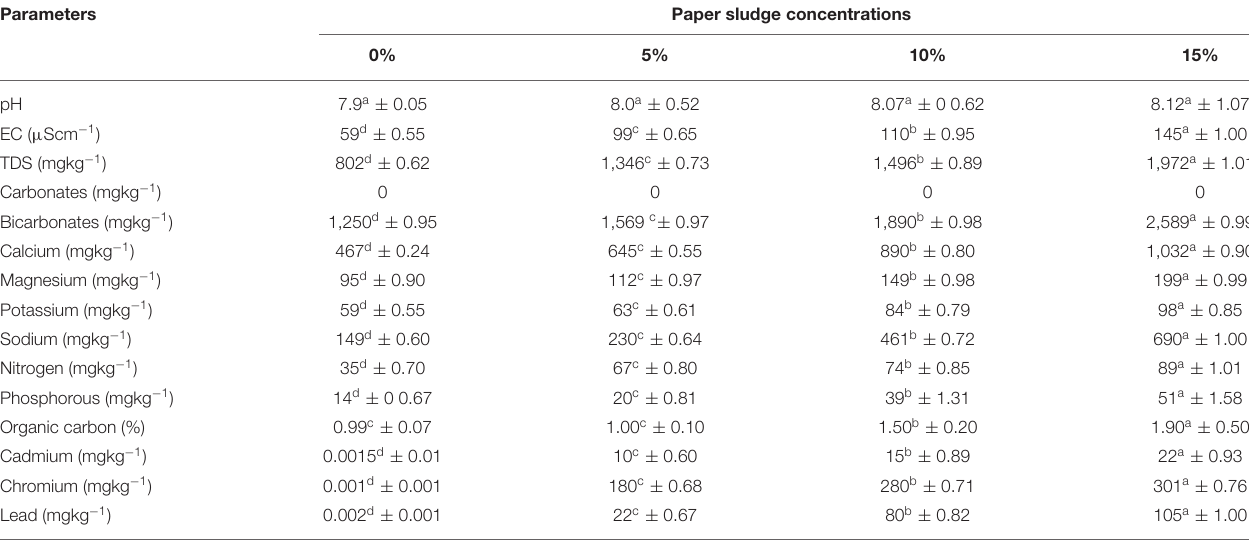
TABLE 5 | Postharvest analysis of physicochemical parameters of different concentrations of paper sludge after plant harvesting.